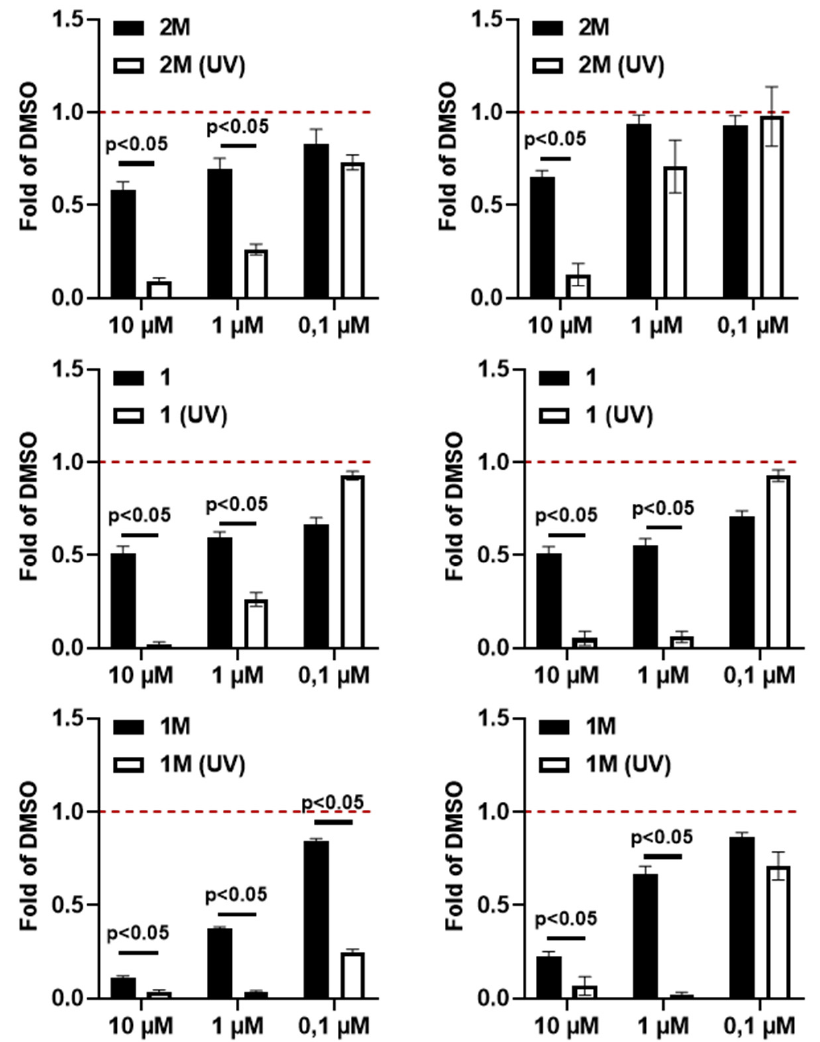
Figure 7. Cell toxicity of 1 , 1M , and 2M in A549 and WI-38 cell lines, with or without exposure to UV light. Data are presented as a fold of control cell treated with an amount of DMSO corresponding to an added aliquot of dye DMSO stock solution (<0.1% DMSO in medium), with ± SD resulting from the four replicates. Representative data from two independent experiments which yielded similar results are shown, with good statistical significance values p < 0.05.